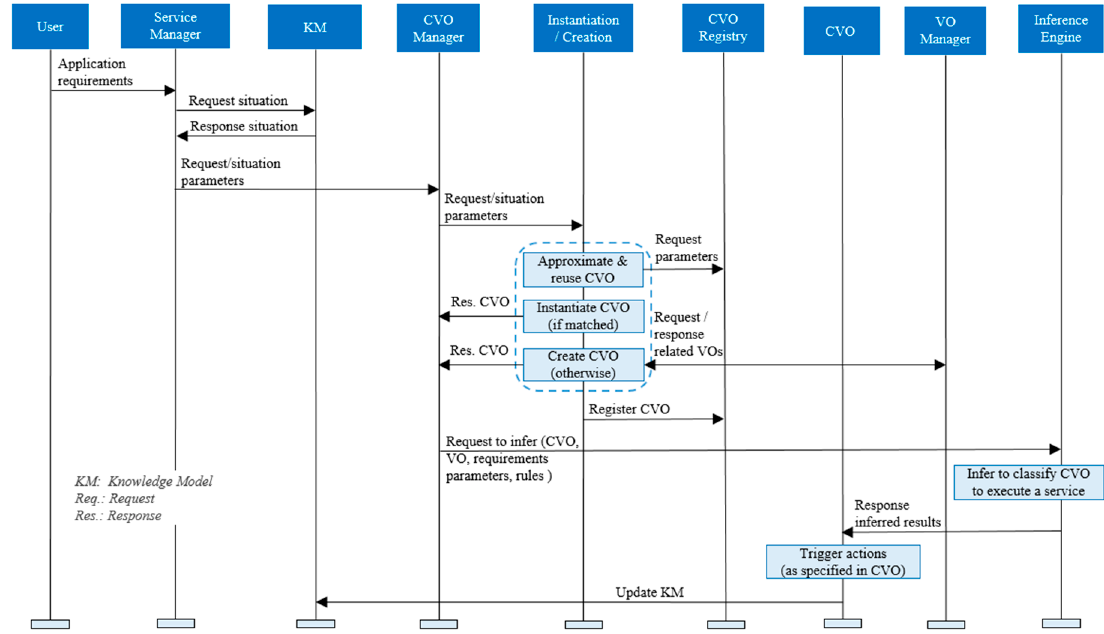
Figure 8. Sequence of instructions in the knowledge base for reusing a CVO in the WoO platform.